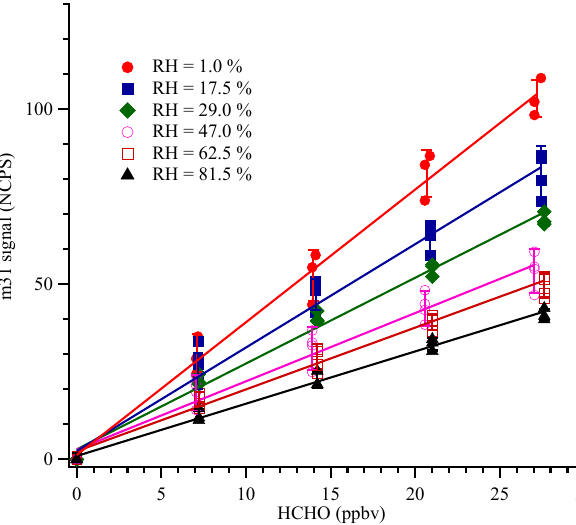
Figure 5. HCHO calibrations conducted at RH = 1–81.5%. Three or four repeated calibrations were performed at each RH setting. The averaged background signals have been subtracted from all cal- ibration data sets. The linear fitting lines are based on the average of each group of calibrations at one RH setting and the corresponding error bars represent 1 standard deviation of each group of calibra-